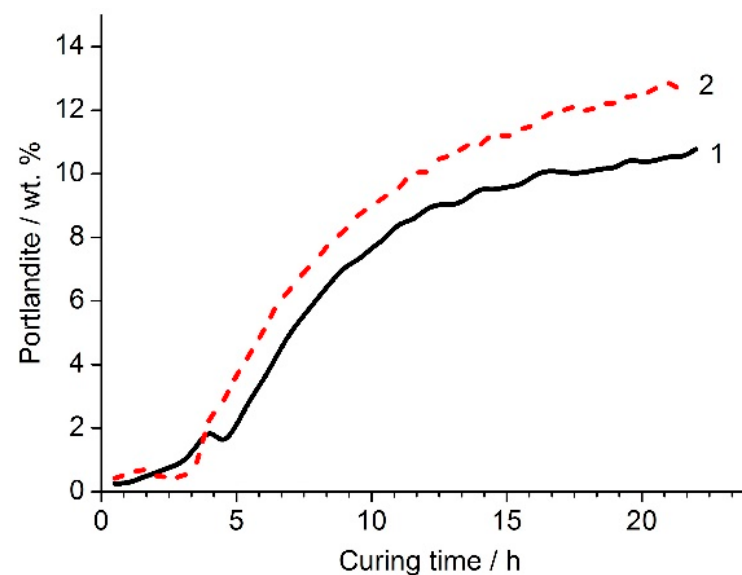
Figure 7. Variation of the portlandite content in the paste as a function of curing time: PC (1) and PC–NC blend (2).